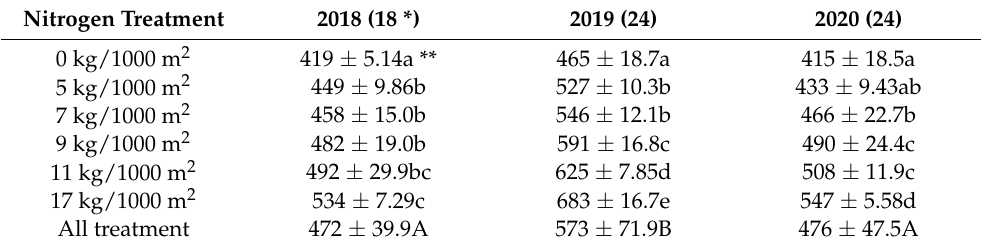
Table 3. Two-sample t-test among rice yields depending on the nitrogen fertilization treatment for each year.